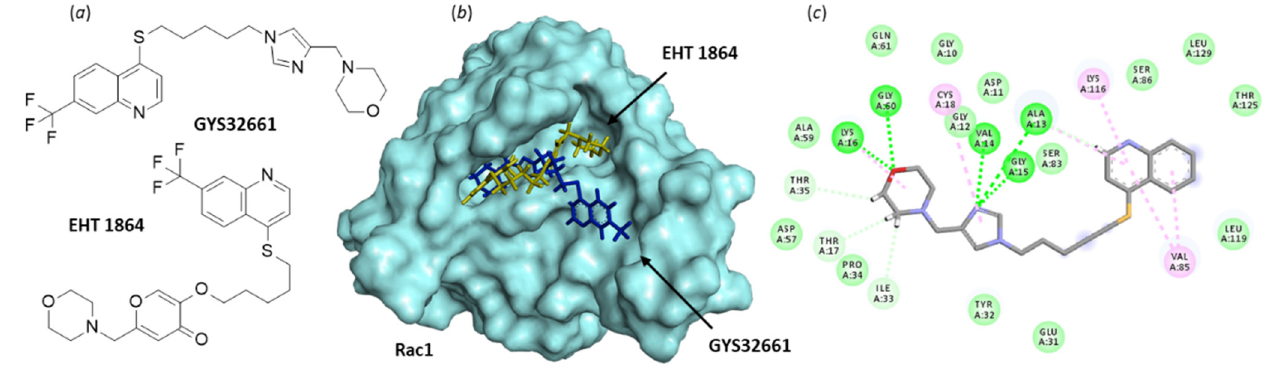
Figure 8. Binding of EHT 1864 and GYS32661 to Rac1. ( a ) Chemical structure of NSC23766. ( b ) Model of Rac1 (molecular surface, PDB: 1MH1) interacting with EHT 1864 (in yellow) and GYS32661 (in blue). The two molecules are superimposed to illustrate their distinct orientation within the binding site. ( c ) The binding map contacts for GYS32661 bound to Rac1. Calculated empirical energy of interaction Δ E = − 143.1 and − 74.7 kcal/mol and empirical energy of hydration Δ G = − 25.8 and 15.7 kcal/mol, for GYS32661 and EHT 1864, respectively.